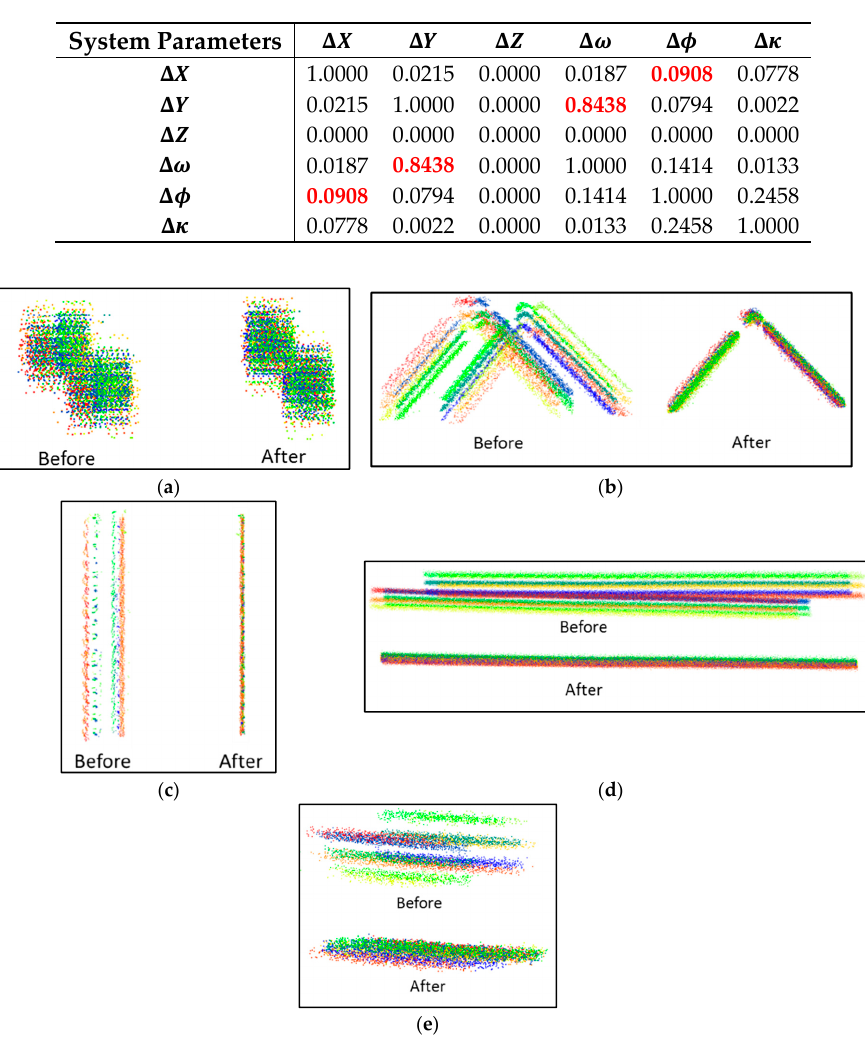
Table 7. Correlation matrix of mounting parameter estimates from calibration test 3 (the potential high correlation values are shown in red).